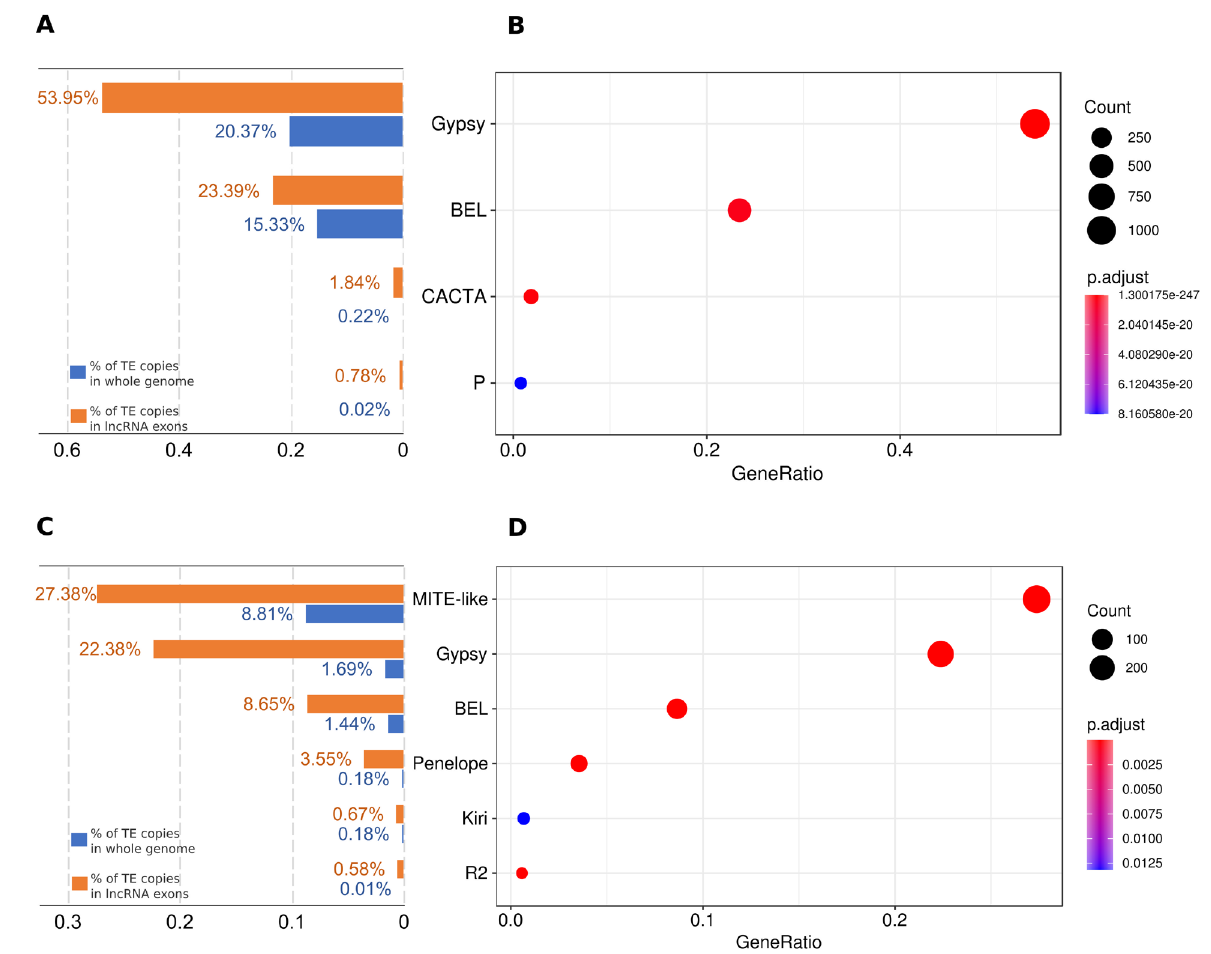
Figure 2 – Over-representation analysis of TE superfamilies in lncRNA exons. Distribution of superfamilies that are enriched in A. albopictus (A) and C. quinquefasciatus (C), a full list of superfamilies is shown in Figure S3. The results of the over-representation analysis show that Gypsy and BEL (LTR retroelements) are the most enriched superfamilies in both A. albopictus (B) and C. quinquefasciatus (D). MITE-like elements are not a TE superfamily as they are a heterogeneous group of defective elements that have